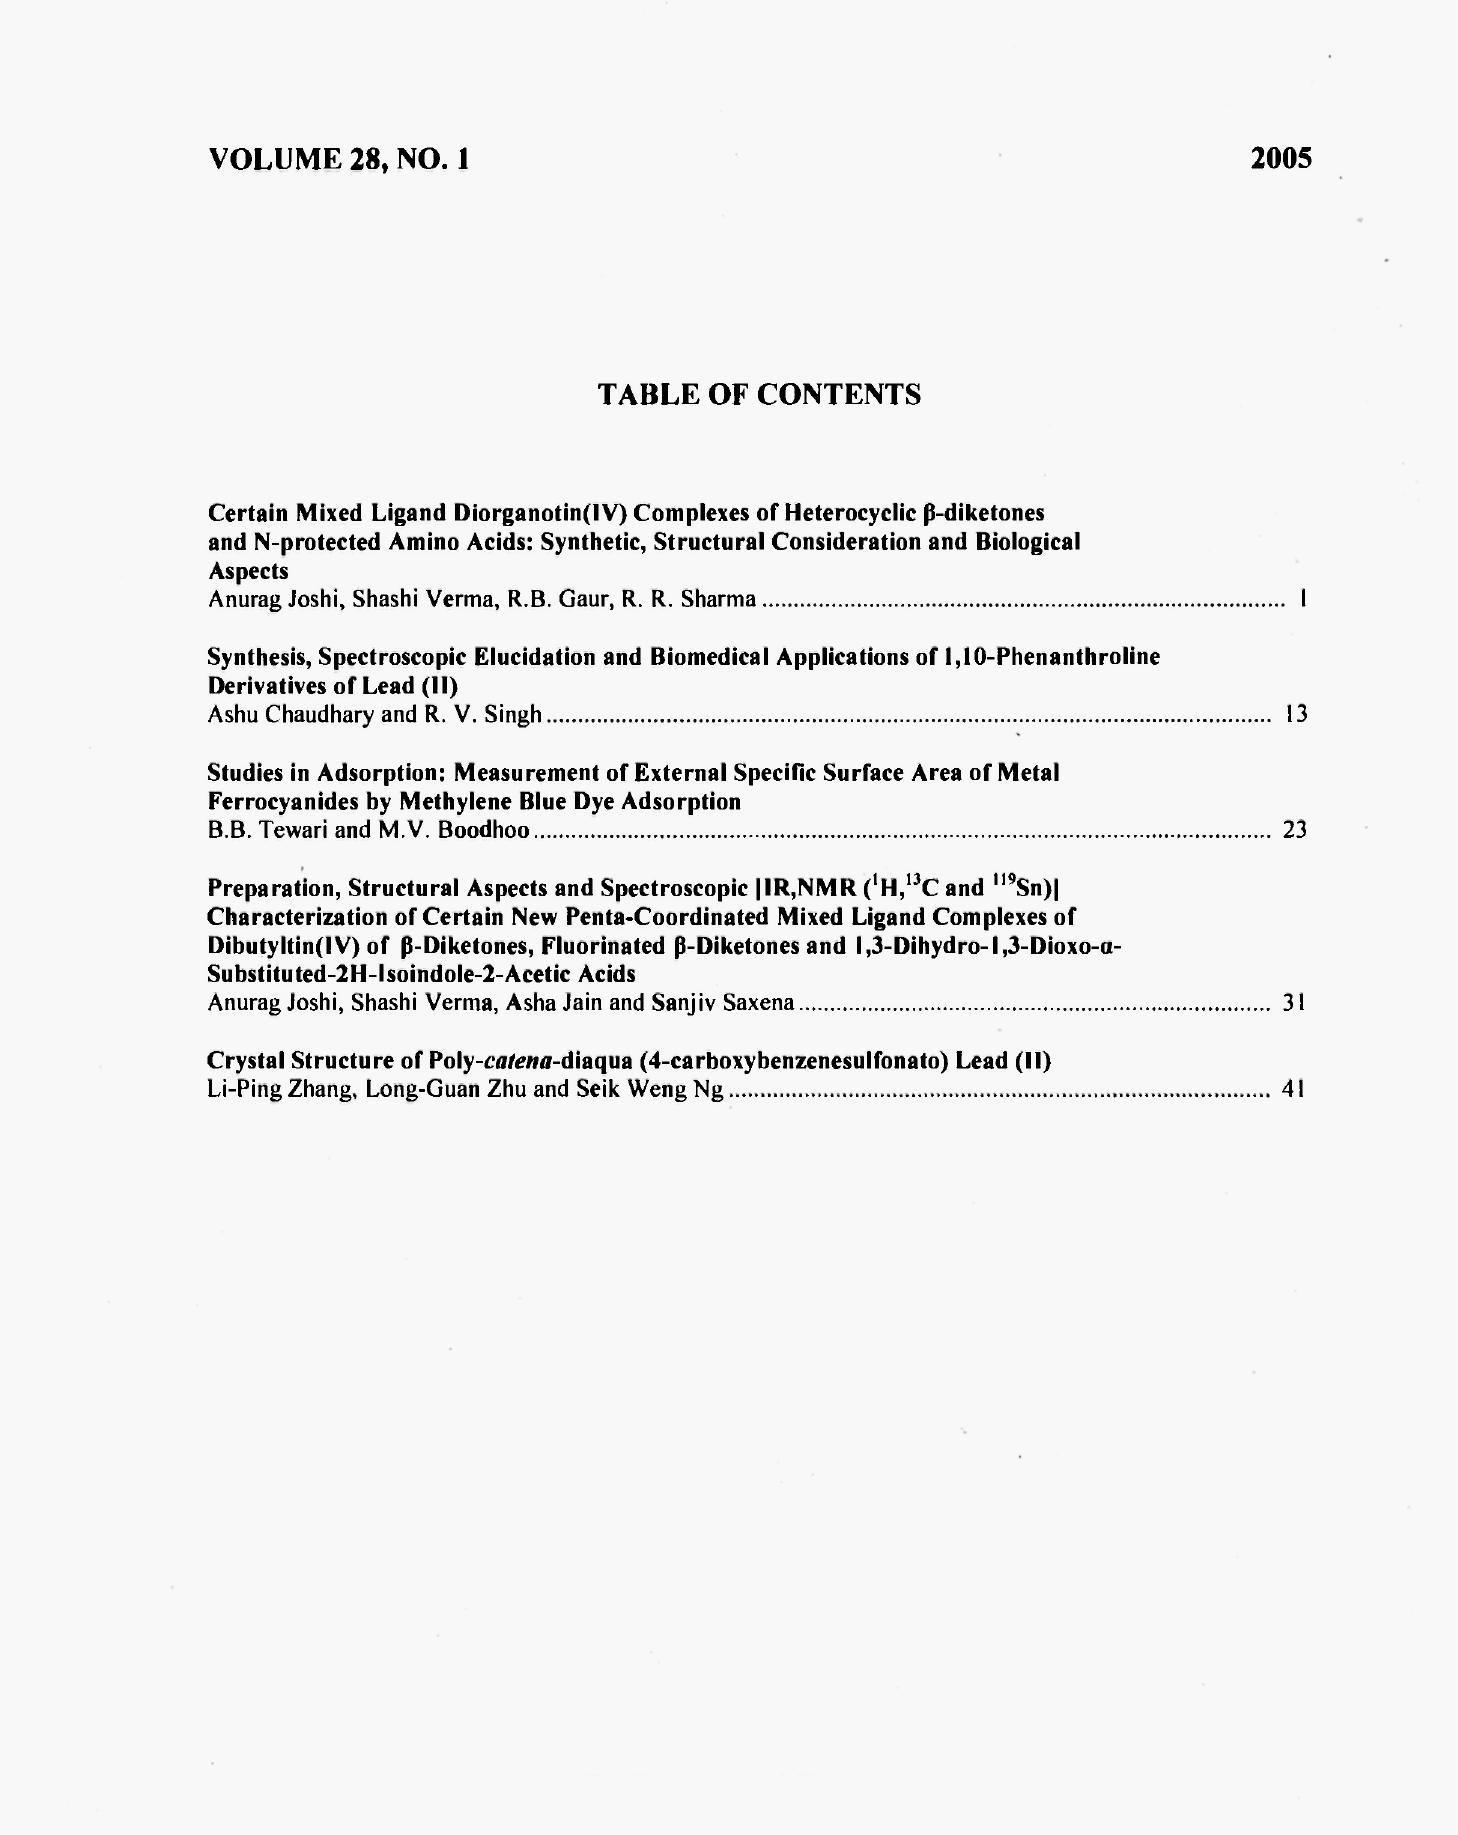
Certain Mixed Ligand Diorganotin(IV) Complexes of Heterocyclic ß-diketones and N-protected Amino Acids: Synthetic, Structural Consideration and Biological Aspects